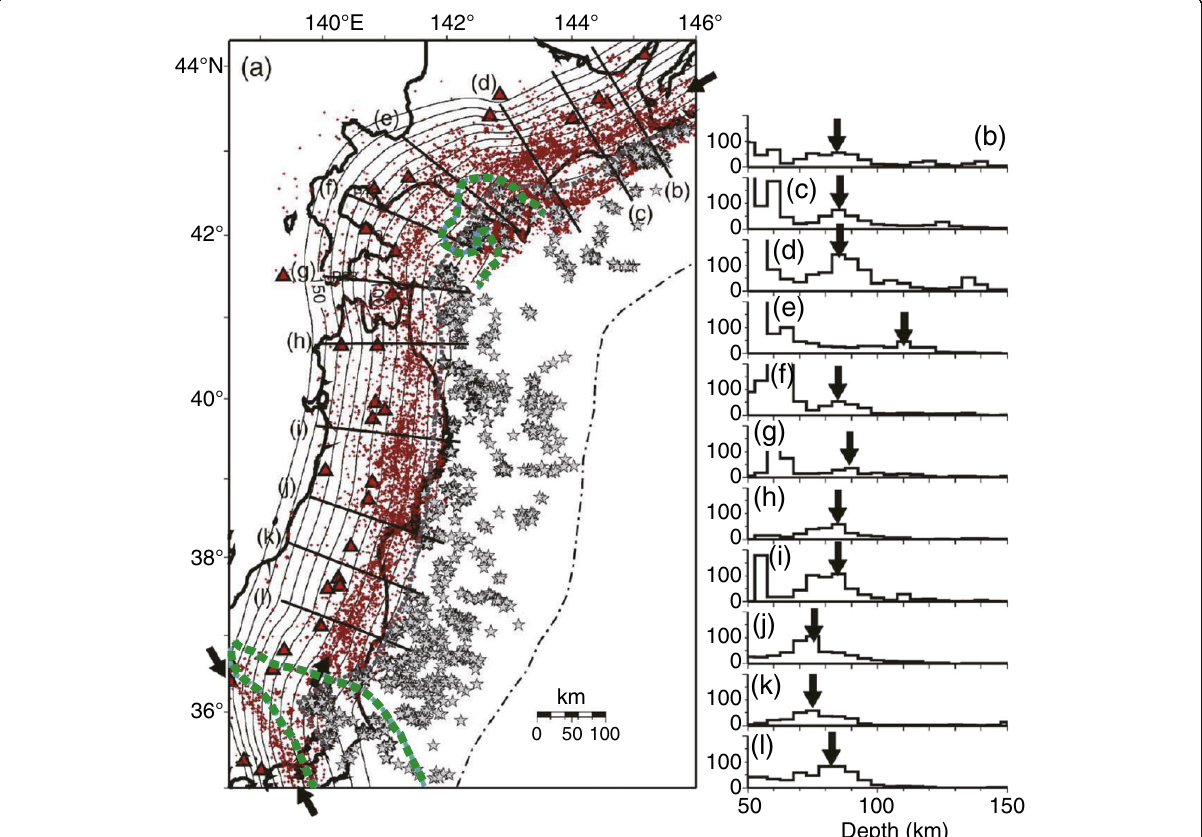
Fig. 7 A belt of upper-plane seismicity in the slab crust. a Hypocenter distribution of earthquakes in the crust of the Pacific Plate subducting under eastern Japan. Events 0 – 10 km below the upper plate surface are shown by red dots. Bold arrows denote estimated locations of the upper-plane seismic belt. The contact zone between the Philippine Sea and Pacific Plate beneath Kanto and that between the subducted crust and the Pacific Plate beneath western Hokkaido are indicated by blue thick broken curves. Solid curves , red triangles , and gray stars denote iso-depth contours of the upper plate surface, active volcanoes, and small repeating earthquakes, respectively. b – l Frequency distributions of upper-plane events along the lines b through l in Fig. 7a plotted against depth. Frequency is plotted for intervals of 10 km. The black arrows show the peak that corresponds to the upper-plane seismic belt. (After Kita et al.